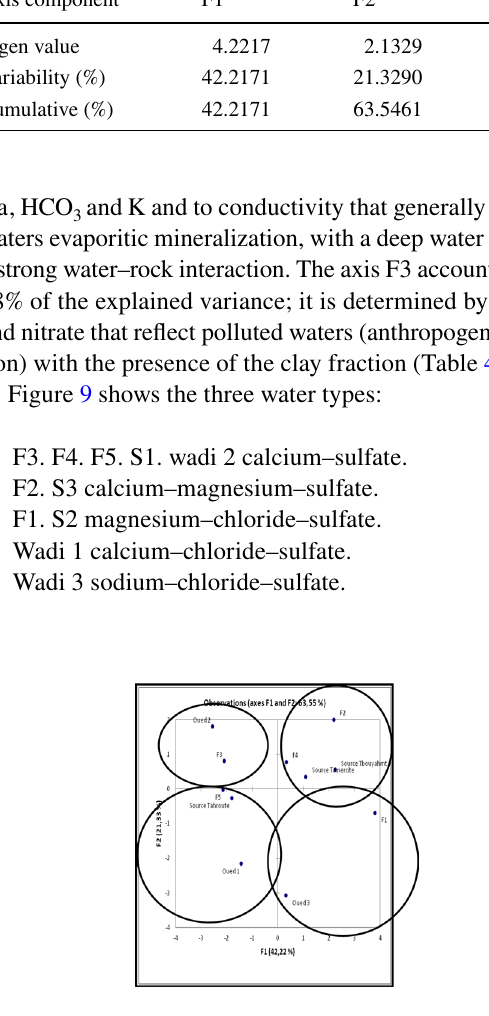
Table 4 Proper values of the first three axes CPA Axis component